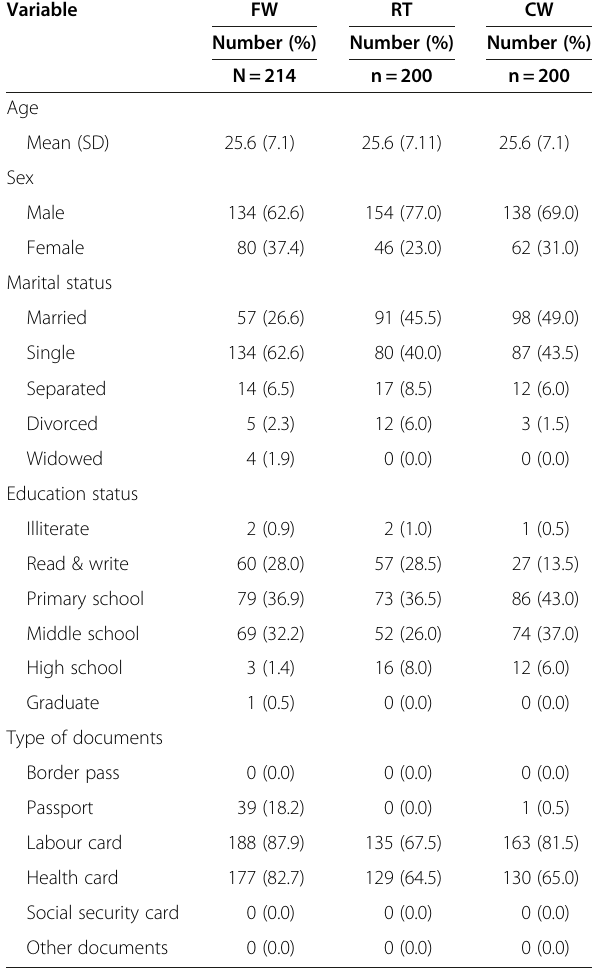
Table 1 Socio-demographic variables of migrant workers by